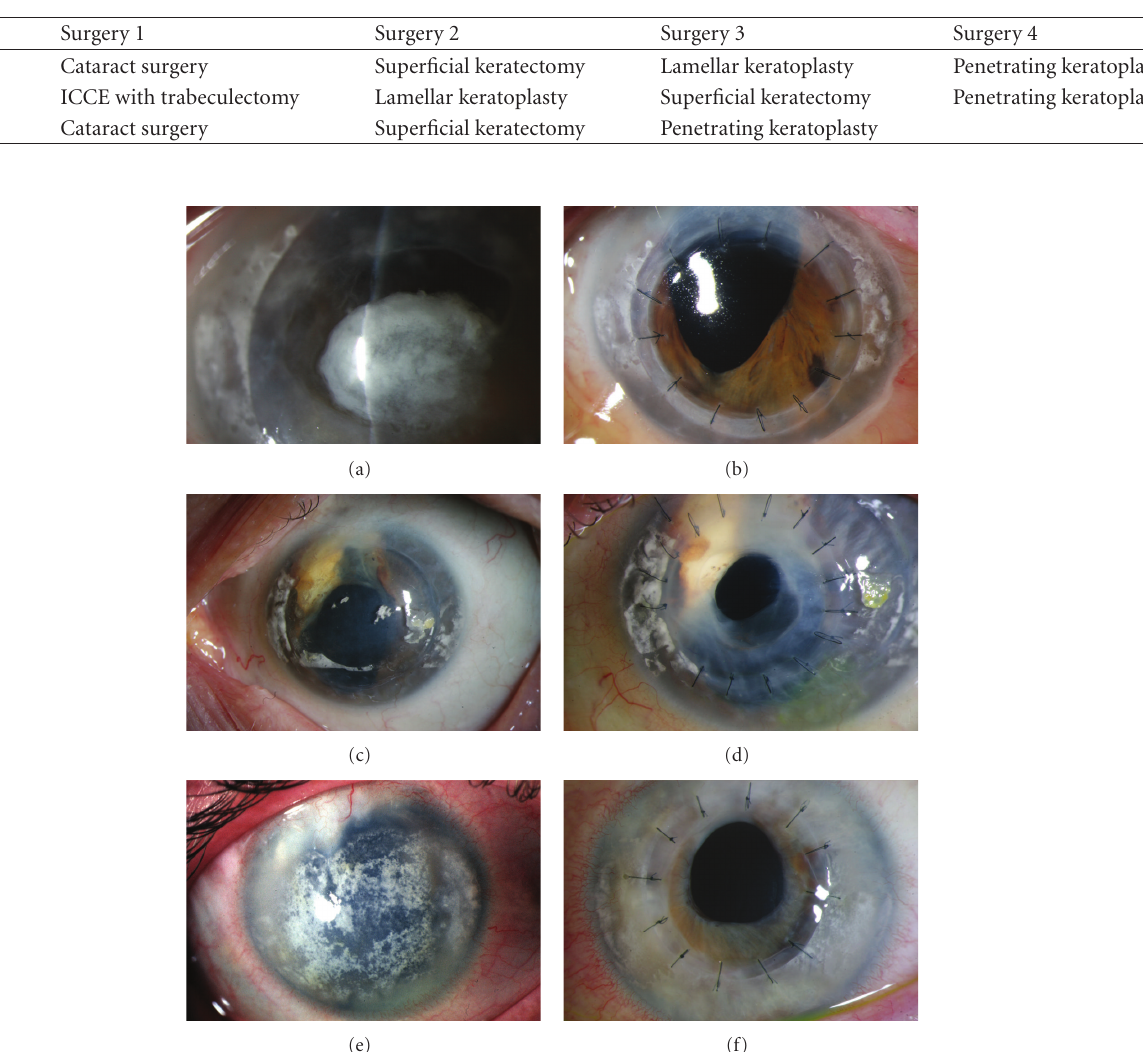
Table 1: This table shows the list of procedures before PK in the sympathising eye.